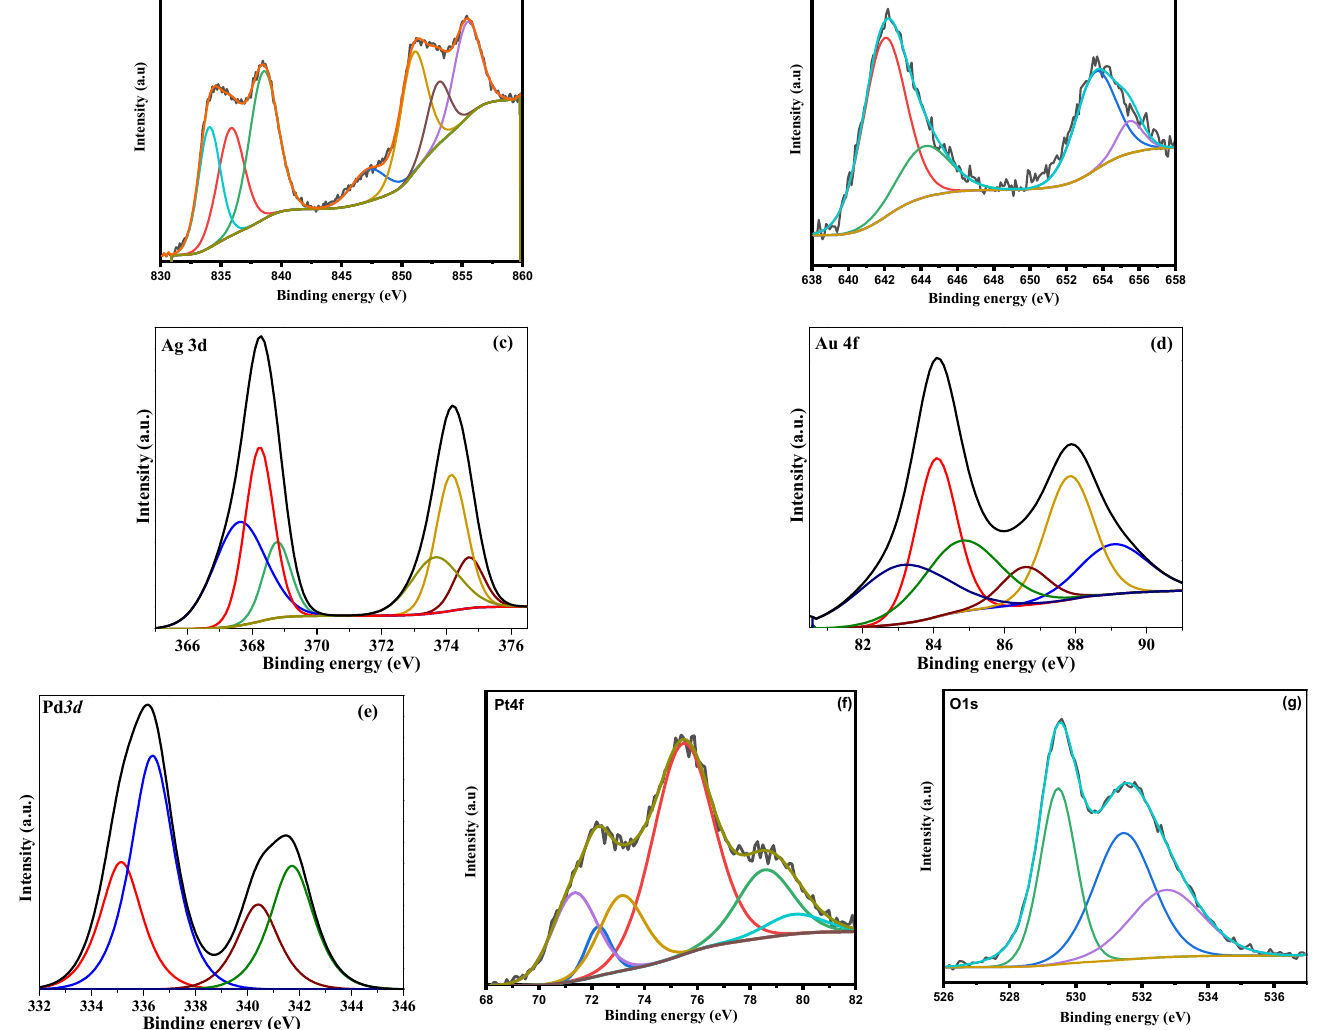
Figure 8. XPS spectra of ( a ) La3d ( b ) Mn2p, ( c ) Ag3d ( d ) Au4f ( e ) Pd3d (d), ( f ) Pt4f and ( g ) O1s.